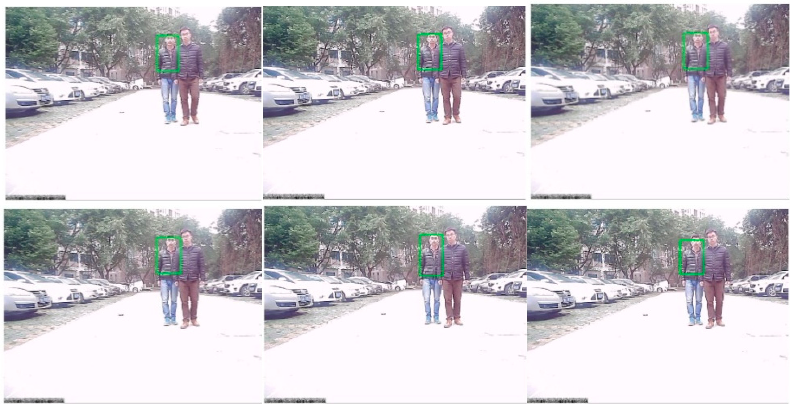
Figure 21. Tracking results based on a particle filter using low-rank representation.